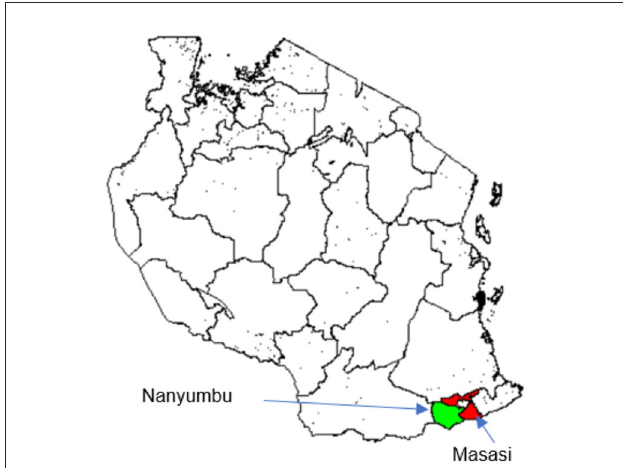
FIGURE1 Map of Tanzania showing location of the study districts, Masasi (red) and Nanyumbu